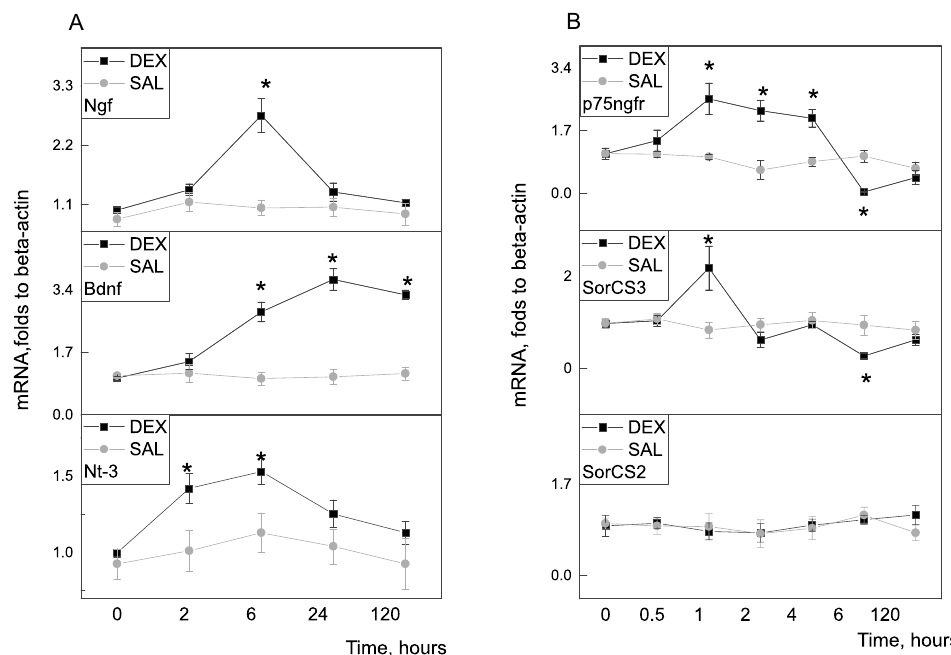
Figure 1. Effects of single DEX injection 0.2 mg/kg to P2 rat pups on neurotrophins in the HPC ( A ) and their receptors in the brainstem ( B ) expression changes. A- Ngf, Bdnf, Nt-3 timeline expression profile in the HPC after DEX administration B- timeline expression profile of p75ngf, Sorcs2, Sorcs3 in brainstem. ONE WAY ANOVA, * p < 0.05 compared to the control group. Data are presented as M ± SE.